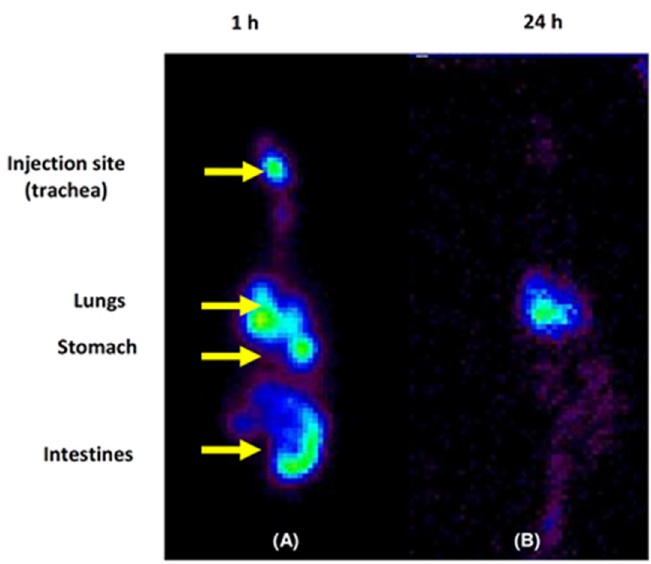
Figure 6. Biodistribution of 99mTc radiolabeled Soluplus ® (man)micelles (1.85 MBq). Static images were acquired 1 ( A ) and 24 h ( B ) post intratracheal administration by means of a surgical puncture tracheotomy. Anesthesia: isofluorane. After 24 h post-administration, almost 100% of the 99mTc (man)micelles of the intratracheal route remained in the lungs (color intensity in the image is not corrected by physical decay of the signal).